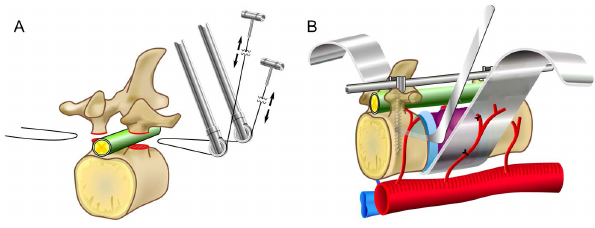
Figure 1. Operative schema for total en bloc spondylectomy. (A) Pediculotomy using a T-saw and en bloc resection of the posterior element; (B) Anterior column osteotomy and removal of the tumor- affected vertebral body.